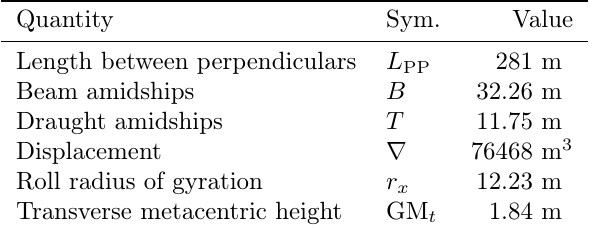
Table 2: 2 nd -order hydrostatic restoring coefficients Heave